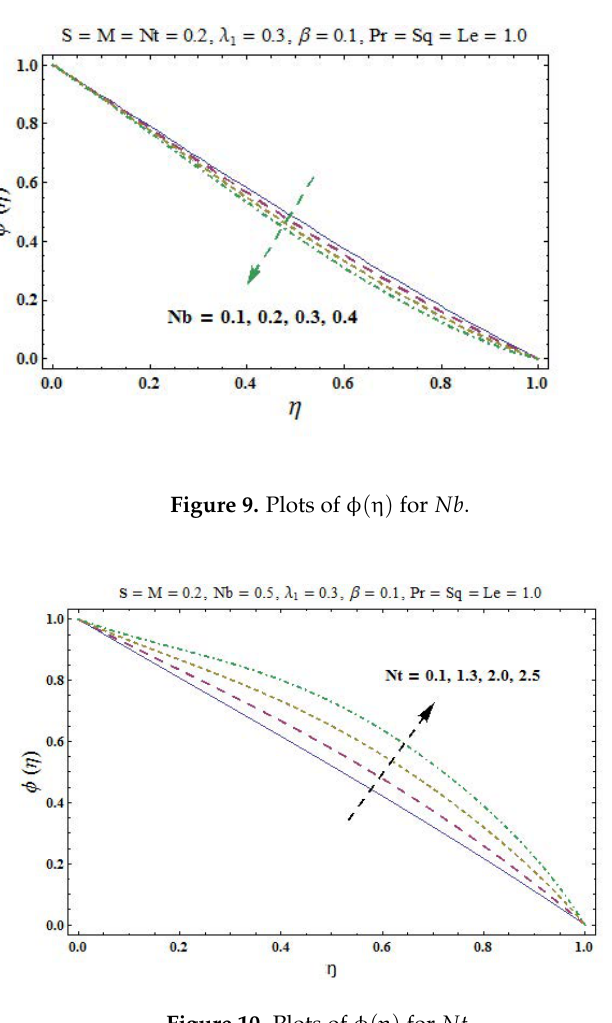
Figure 10. Plots of φ ( η ) for Nt .